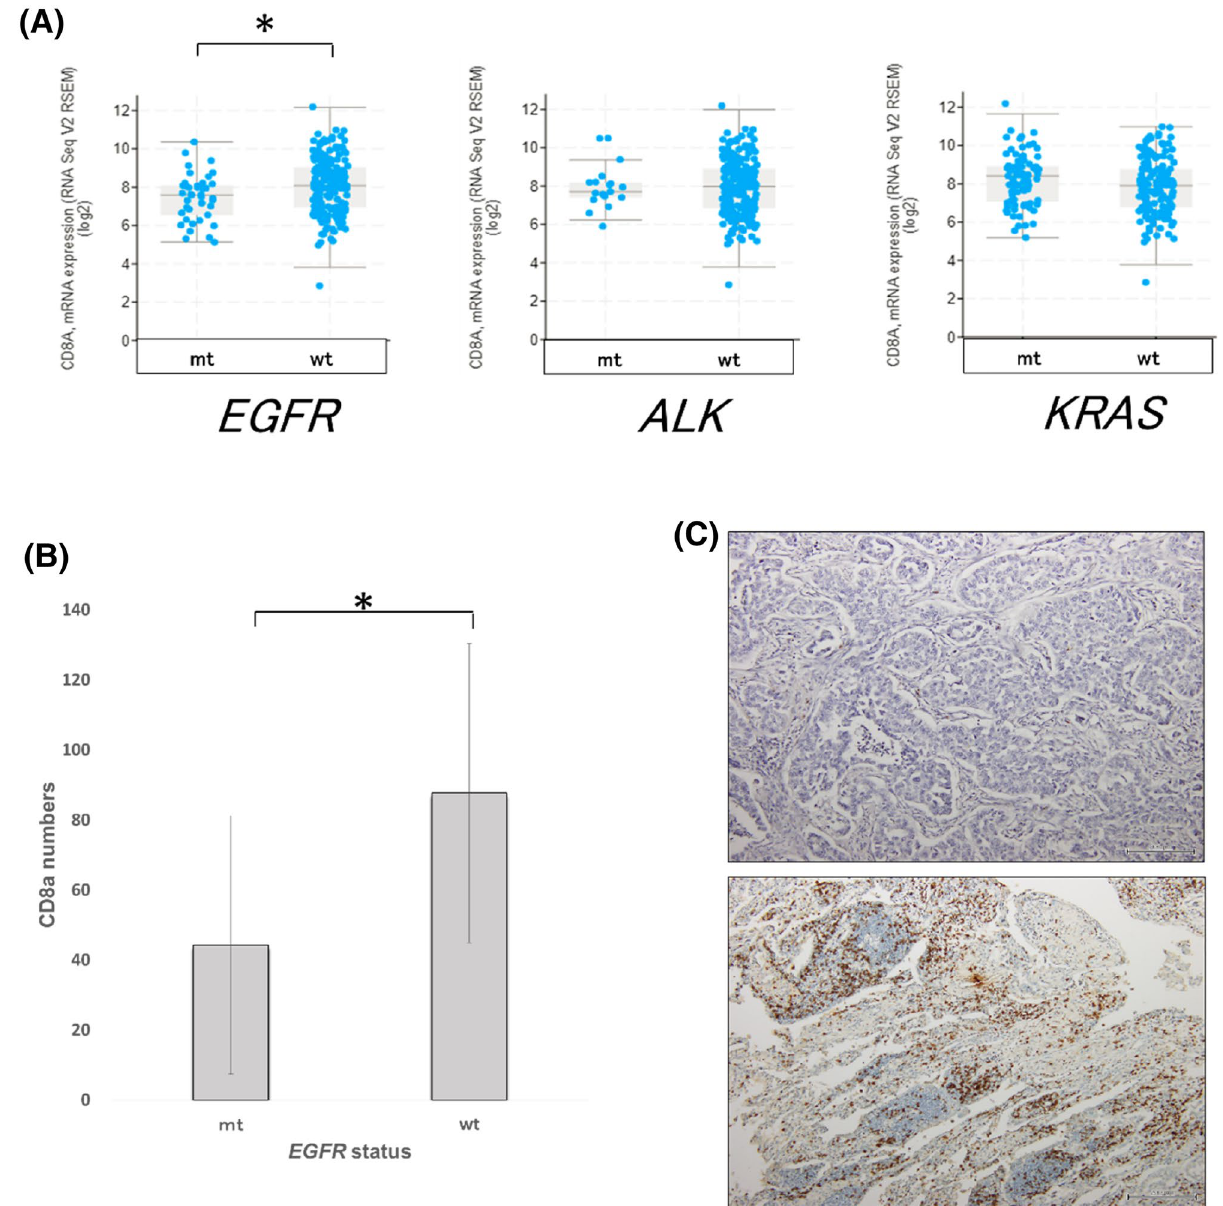
Figure 1. EGFR-mutated ( EGFR -mt) lung adenocarcinoma (LA) exhibits a lower number of CD8 + T cells than LA with wild-type EGFR ( EGFR -wt) LA. ( A ) Comparative analysis of the CD8A mRNA levels in human LA (TCGA, Nature 2014) according to the mutational status of EGFR , ALK , and KRAS . EGFR mt (n = 40; 17%), ALK -mt (n = 19; 8%), and KRAS -mt (n = 83; 36%). *p < 0.01. ( B ) Comparison of the CD8a-positive cells between EGFR -mt (n = 56) LA and EGFR -wt (n = 84) LA using immunohistochemical analysis (IHC). Mean CD8a- positive cells in three 200 × 200 µm 2 areas were calculated for each sample. Vertical bars indicate the mean CD8a cells and the error bars indicate the standard deviation. *p < 0.0001. ( C ) Representative IHC images. Upper and lower panels indicate EGFR -mt and EGFR -wt LA, respectively. Horizontal scale bar: 200